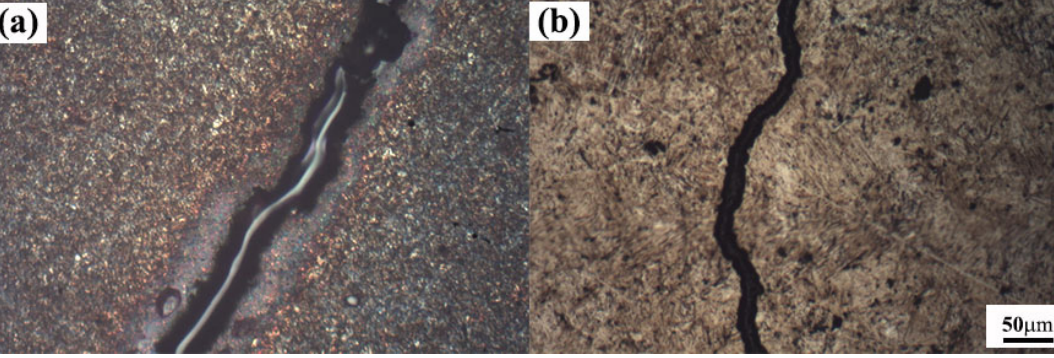
Figure 7. Quenching crack images of specimen quenched in (a) regular tap water, and (b) magnetically treated tap